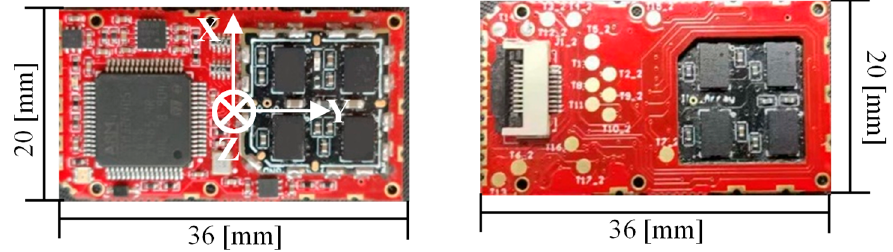
Figure 1. The in-house developed inertial measurement unit (IMU) array platform.